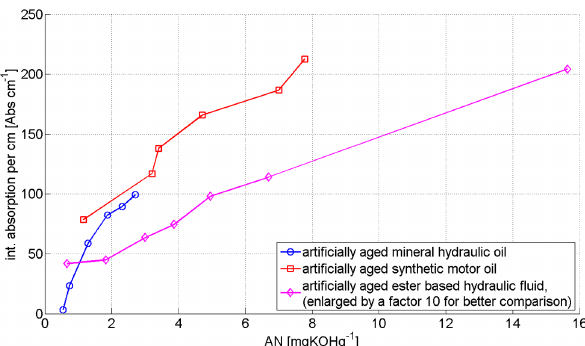
Figure 8. FTIR absorption integrated over the oxidation band plot- ted vs. acid number (AN) as determined by ASTM D974; evaluated spectral regions are 3333cm − 1 with FHWM 52cm − 1 for the arti- ficially aged ester-based hydraulic fluid (corresponding to filter B1) and 1722cm − 1 with FWHM 151cm − 1 , corresponding to filter A1, for the other artificially aged samples (synthetic motor oil, mineral hydraulic oil).